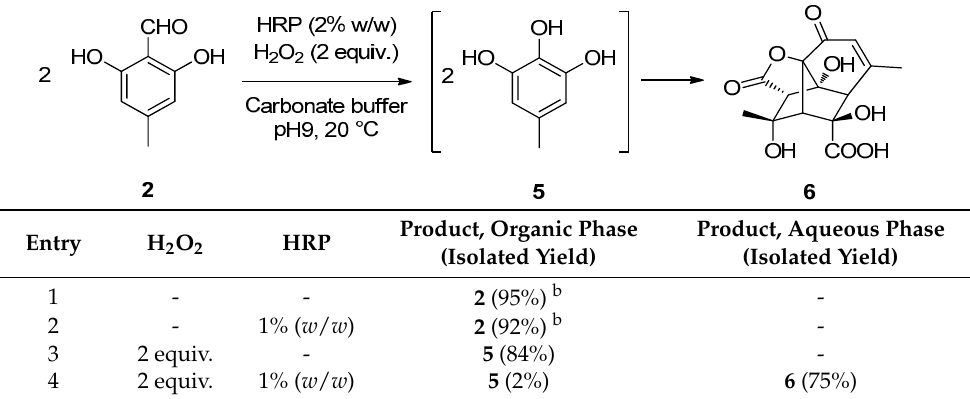
Table 1. Control experiments for the formation of 5 and 6 a .